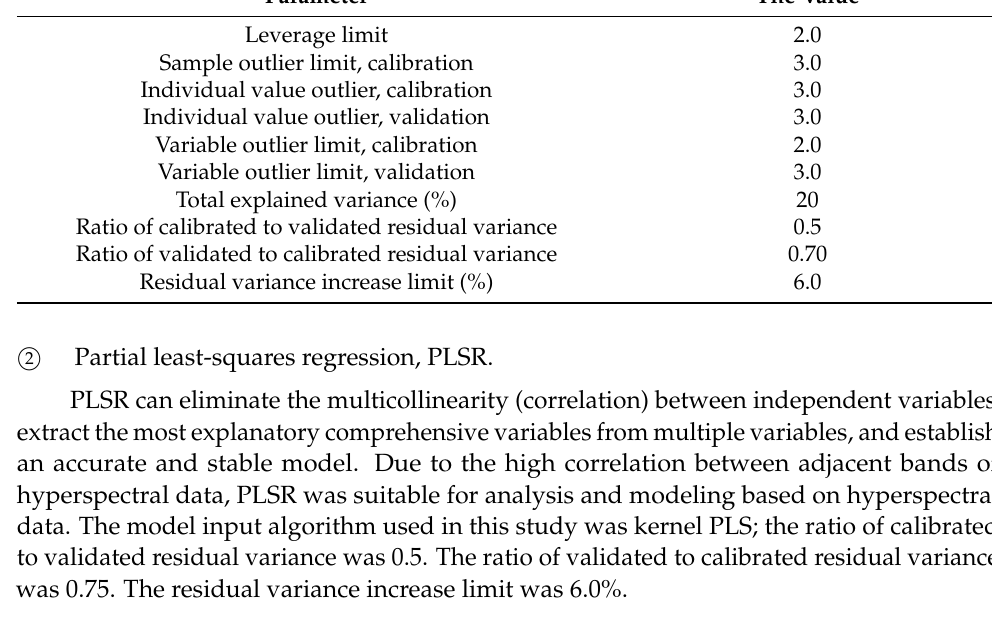
Table 2. Relevant parameters used in multiple linear regression (MLR) in this study.